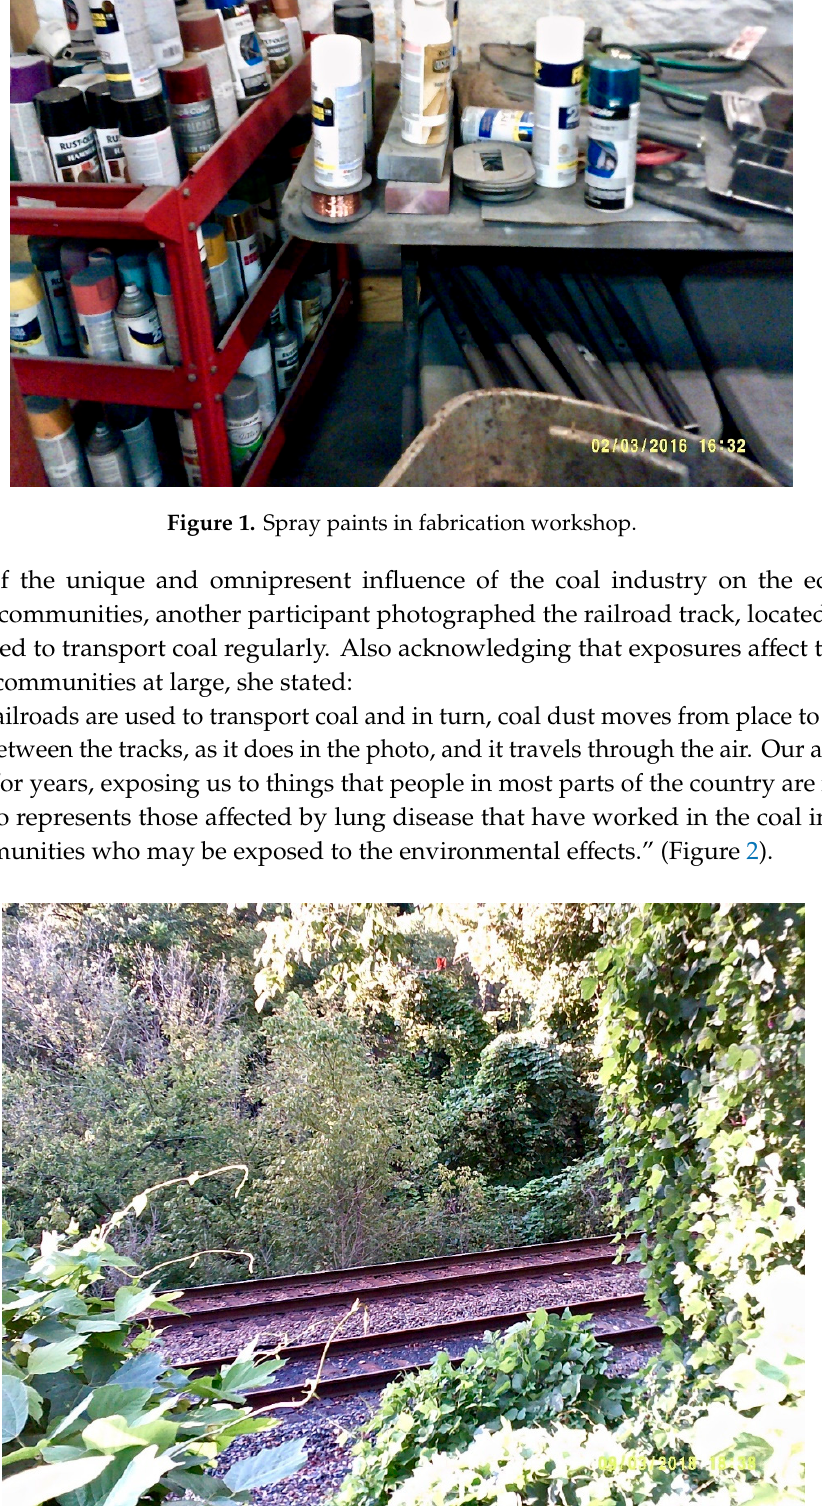
Figure 2. Railroad used for coal transport .